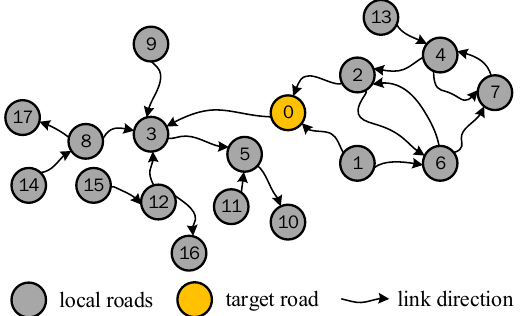
Figure 8. Structure of the road network considered in the